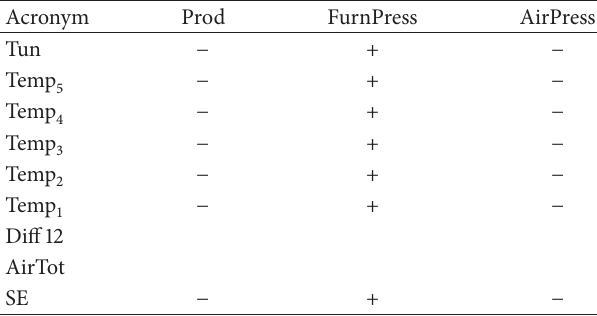
Table 5: The CVs-DVs mapping matrix.